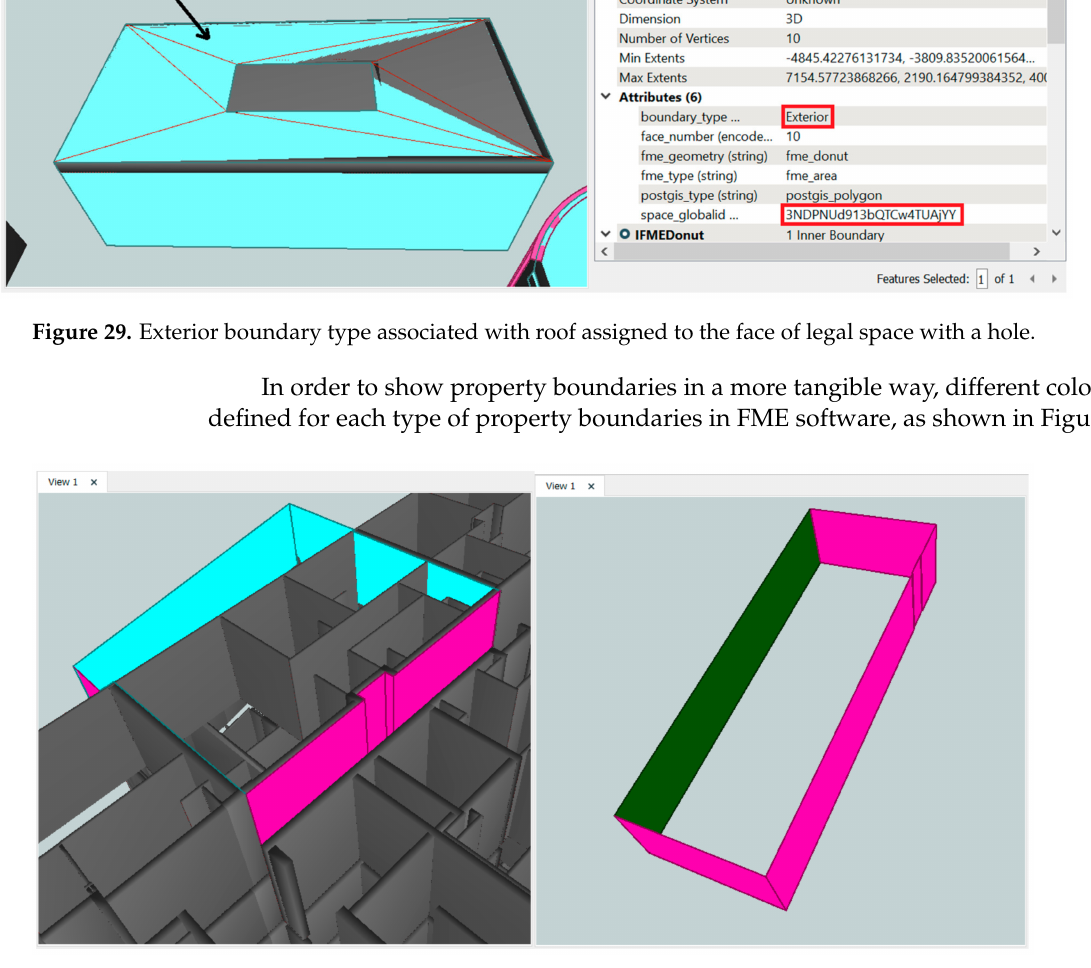
Figure 30. Defining colors based on boundary_type attribute in FME software (pink: Exterior boundary, cyan: Interior boundary, green: Median